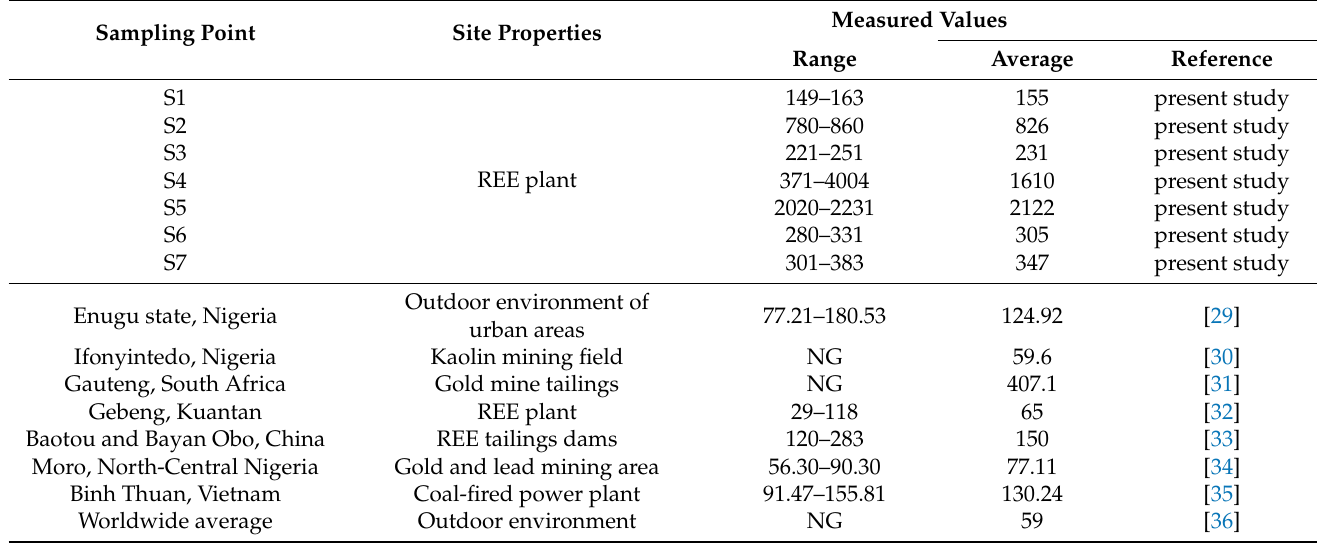
Table 3. Measured results of air-absorbed dose rate of γ radiation (nGy · h − 1